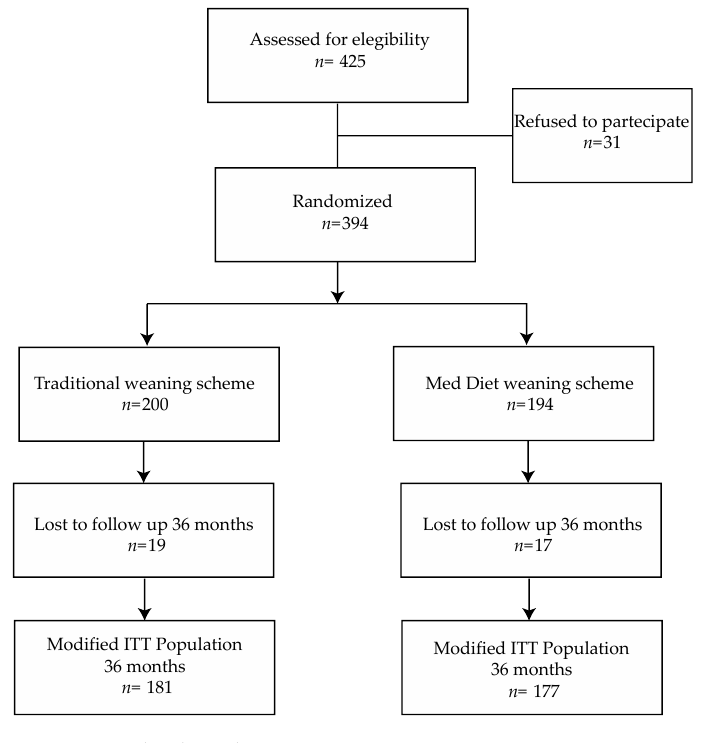
Figure 1. Study Flow-chart. Table 1. Clinical ad demographical characteristics of the sample stratified by treatment arm. Variables are described by mean ± standard deviation (min to max) or absolute frequencies